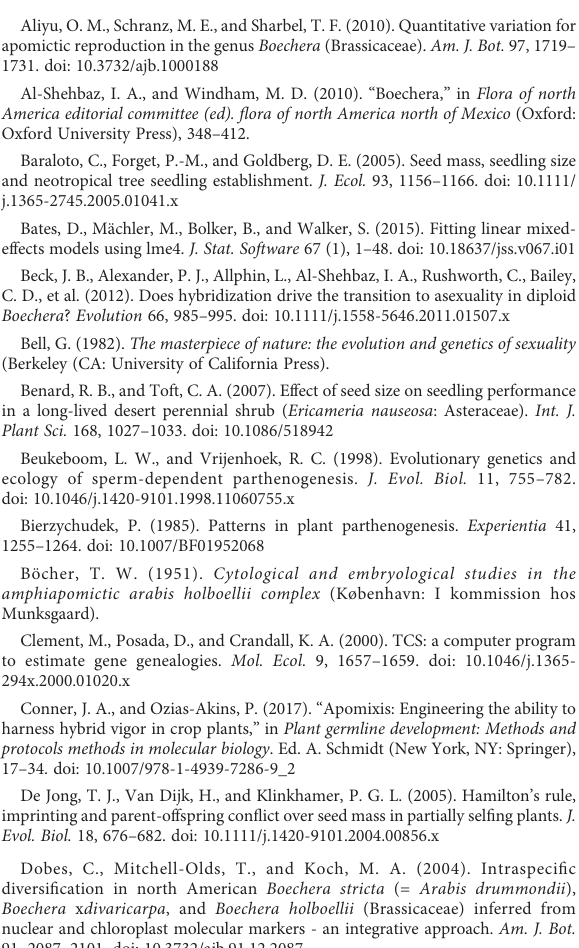
SUPPLEMENTARY TABLE 1 Information about Boechera accessions used in the